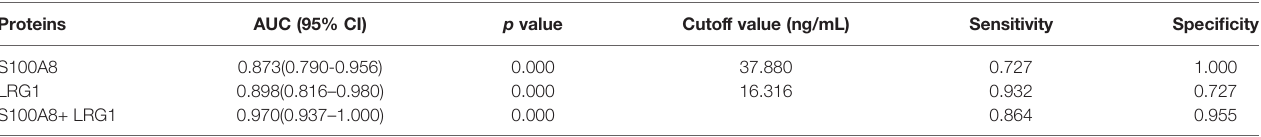
TABLE 4 | Receiver operating characteristics curves of the DEPs S100A8 and LRG1 in distinguishing pediatric NHL patients from healthy controls individually and in combination.